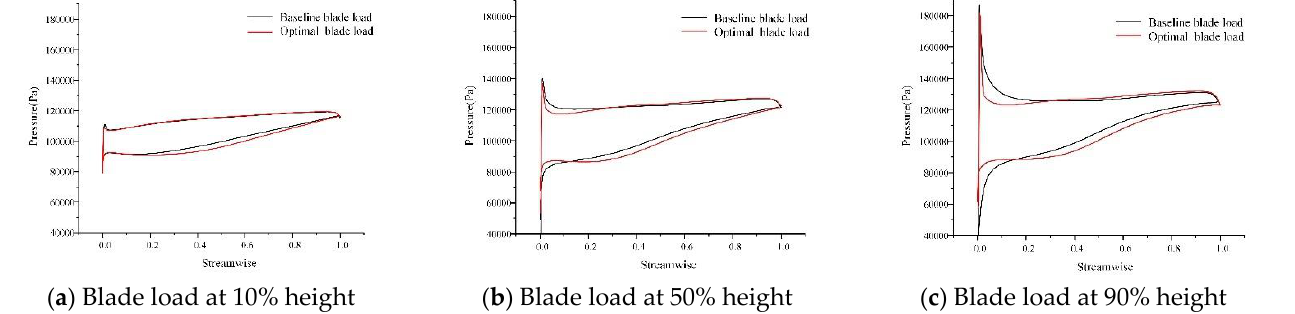
Figure 10. Blade loads of baseline pump and optimal pump.